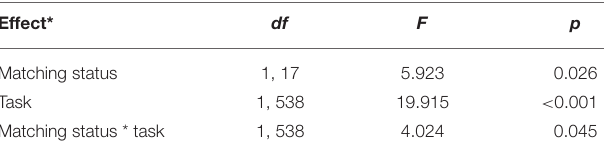
TABLE 8 | Mixed effects ANOVA (matching status and task) for included